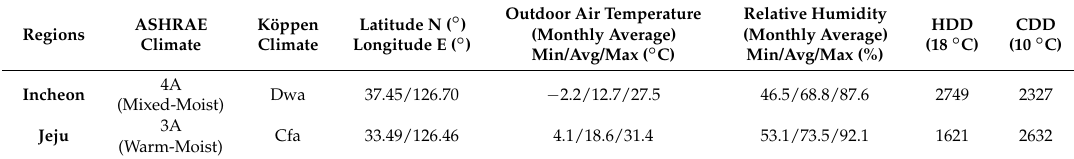
Table 1. Detailed climate characteristics of the two regions.